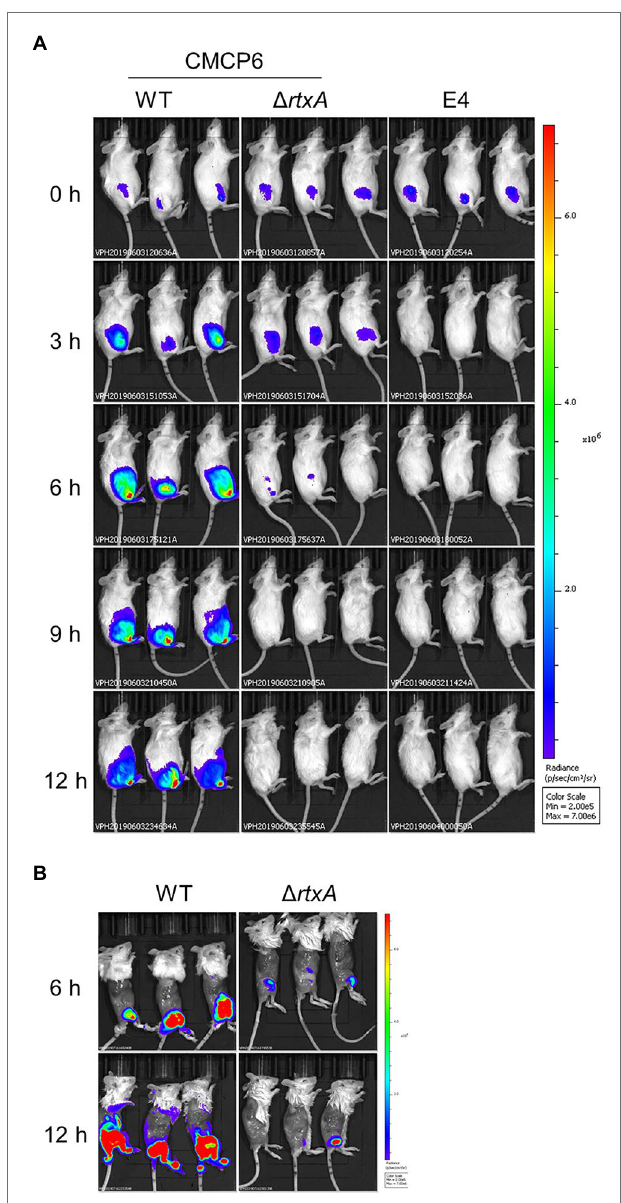
FIGURE 5 | Spread and proliferation in soft tissues. (A) The luminescence signal of CMCP6 wild type (WT), CMCP6 Δ rtxA , and E4 detected by in vivo imaging system (IVIS) during 3 h time course ( n = 6/group). (B) The luminescence signal of CMCP6 WT and Δ rtxA in the skinned mice detected by IVIS at 6 and 12 h post-infection ( n =